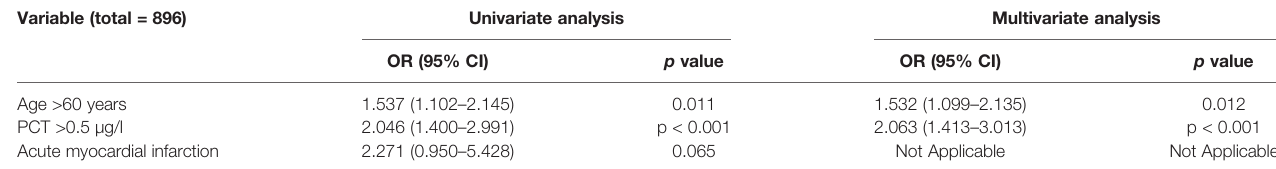
TABLE 1 | Univariate and multivariate analyses of factors related to over 60-day mortality in immunosuppressed patients. Variable (total = 896) Univariate analysis Multivariate analysis OR (95% CI) p